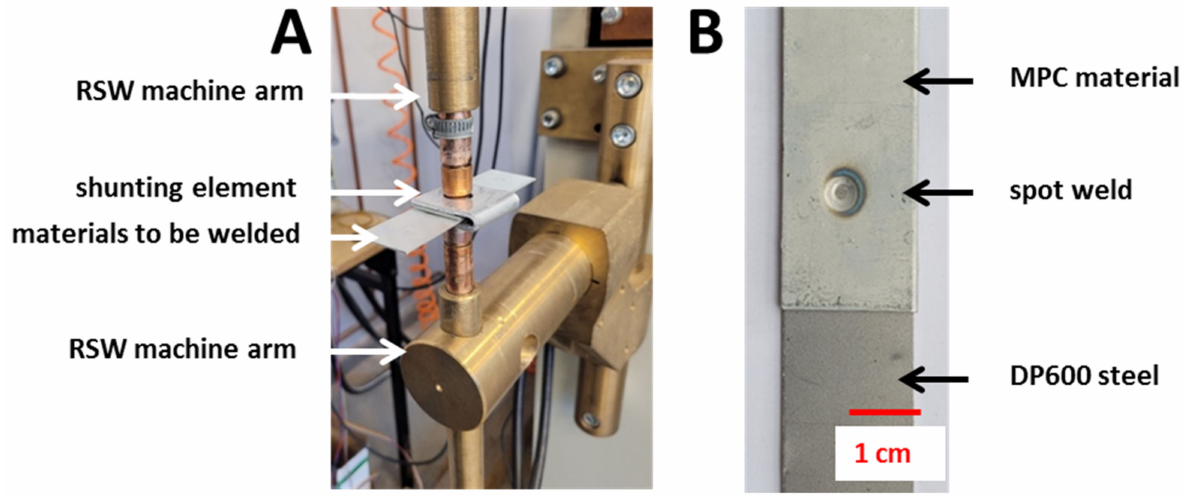
Figure 6. The presentation of: ( A ) sample with applied current shunting element during joining, ( B ) typical test sample, as